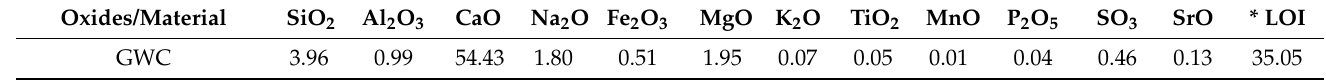
Table 1. Chemical analysis of ground-waste concrete (GWC) (%